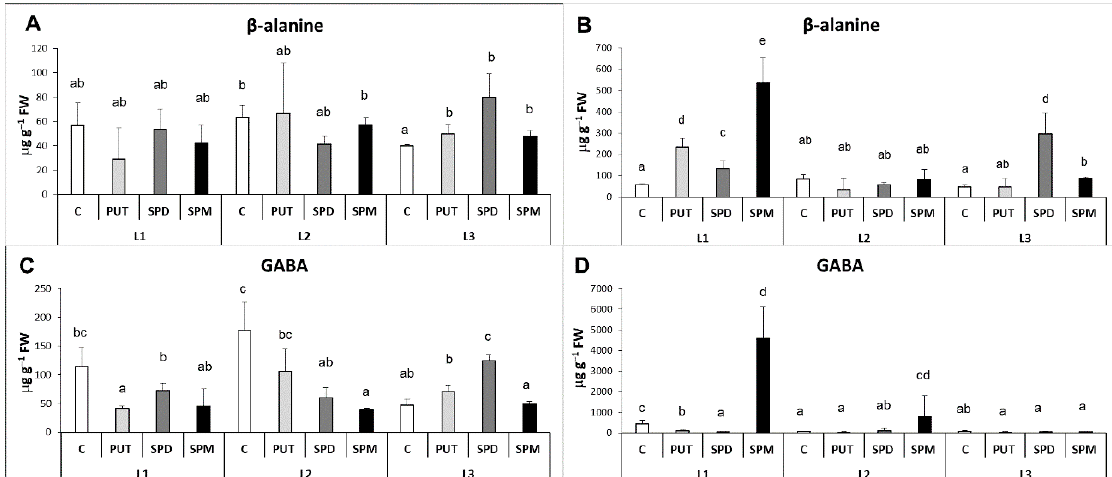
Figure 9. Effect of different light intensities on the levels of β -alanine ( A , B ) and γ -aminobutyric acid (GABA) ( C , D ) in the leaves ( A , C ) and roots ( B , D ) of plants grown under 16 h/8 h day/night light period with different light intensity conditions: 500 (elevated light: L1), 250 (medium light: L2) and 50 (low light: L3) μ mol m 2 s − 1 LED light after 7 days of 0.3 mM exogenous putrescine (PUT), spermidine (SPD) or spermine (SPM) treatments or without any treatment (C). PUT: putrescine, SPD: spermidine, SPM: spermine, GABA: γ -aminobutyric acid. Data represent mean values ± SD. Different letters indicate significant differences at p ≤ 0.05 level, among all the values of the given compounds.